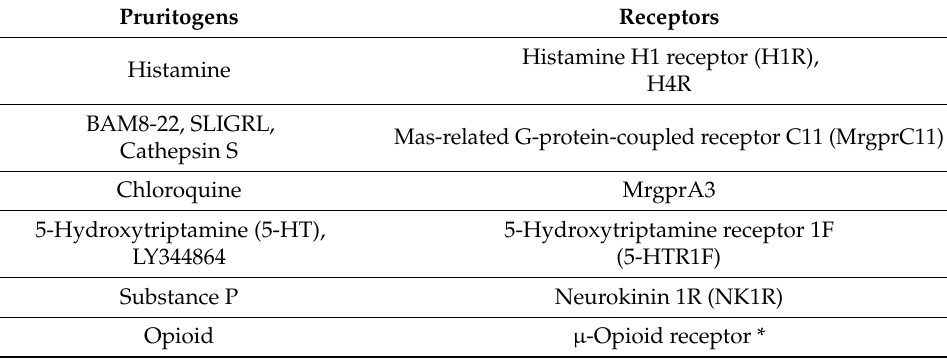
Table 1. Representative pruritogens and their